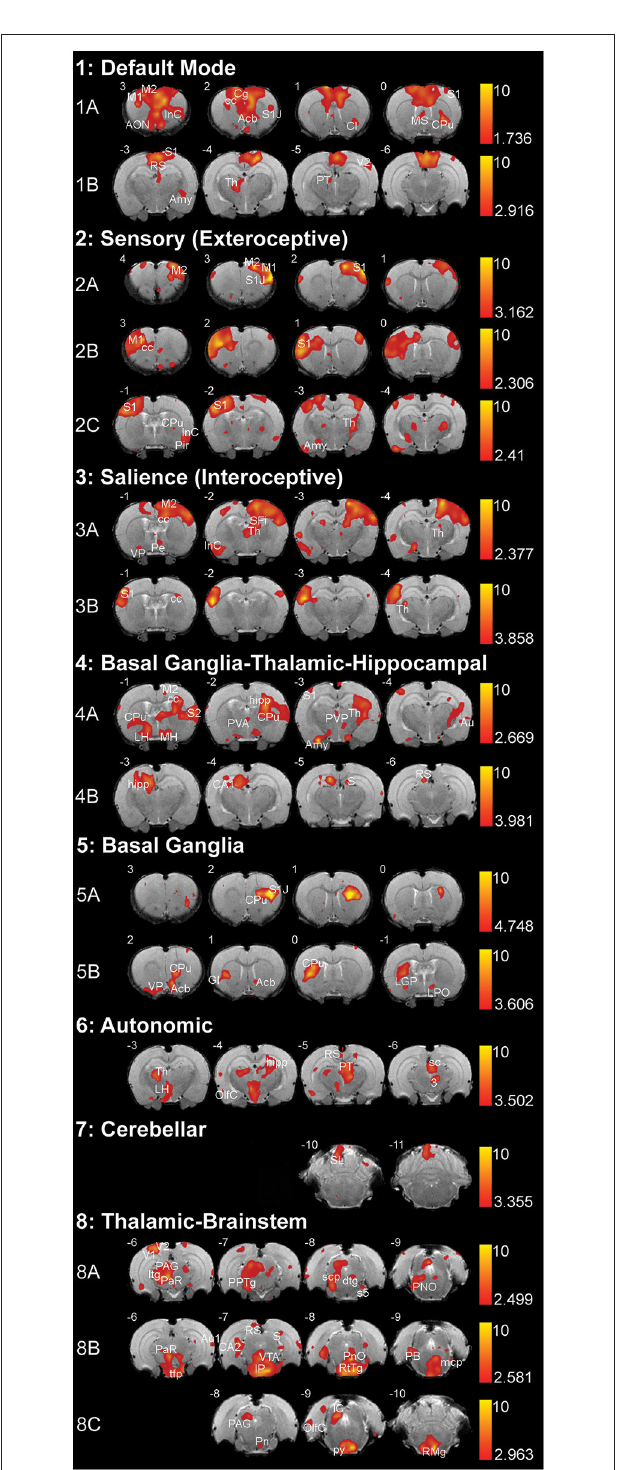
FIGURE 4 | Resting-state networks in 2-week-old rats. The figure illustrates eight different resting-state networks that were identified in 2-week-old rats ( N = 11; 5 female and 6 male from 4 different litters) under light anesthesia. Networks 1–7 showed some spatial similarity to adult networks and included: (1) Default Mode Network, (2) Sensory (Exteroceptive)